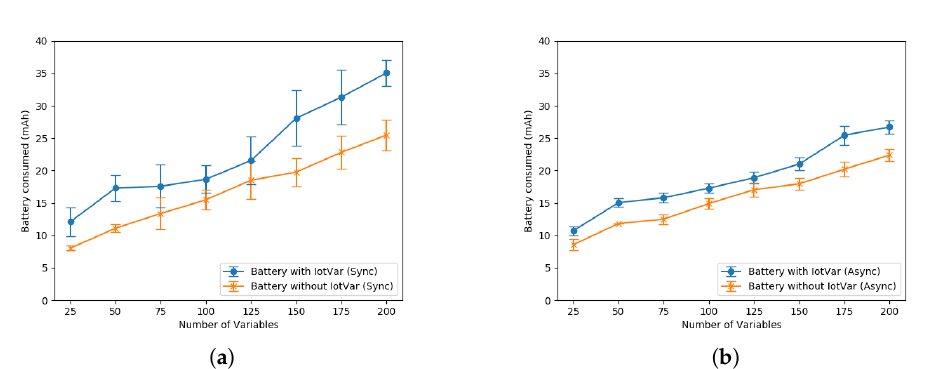
Figure 6. Battery usage for ( a ) a synchronous handling and ( b ) a publish-subscribe